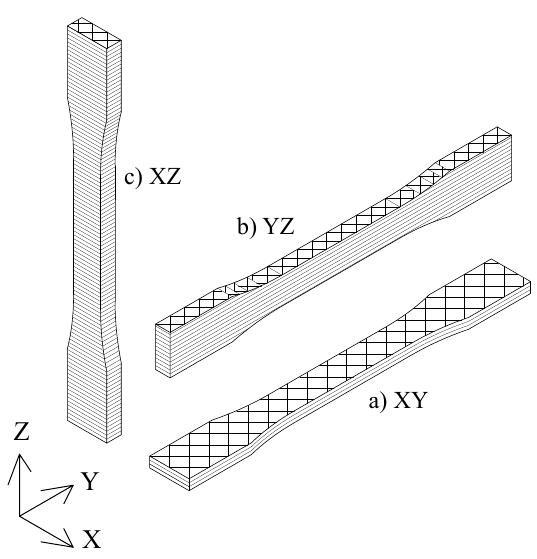
Figure 1. Representative raster and layer configuration for different part build orientations, namely XY, YZ, and XZ. During manufacturing, melted filaments were deposited in the build platform normal to the Z direction.